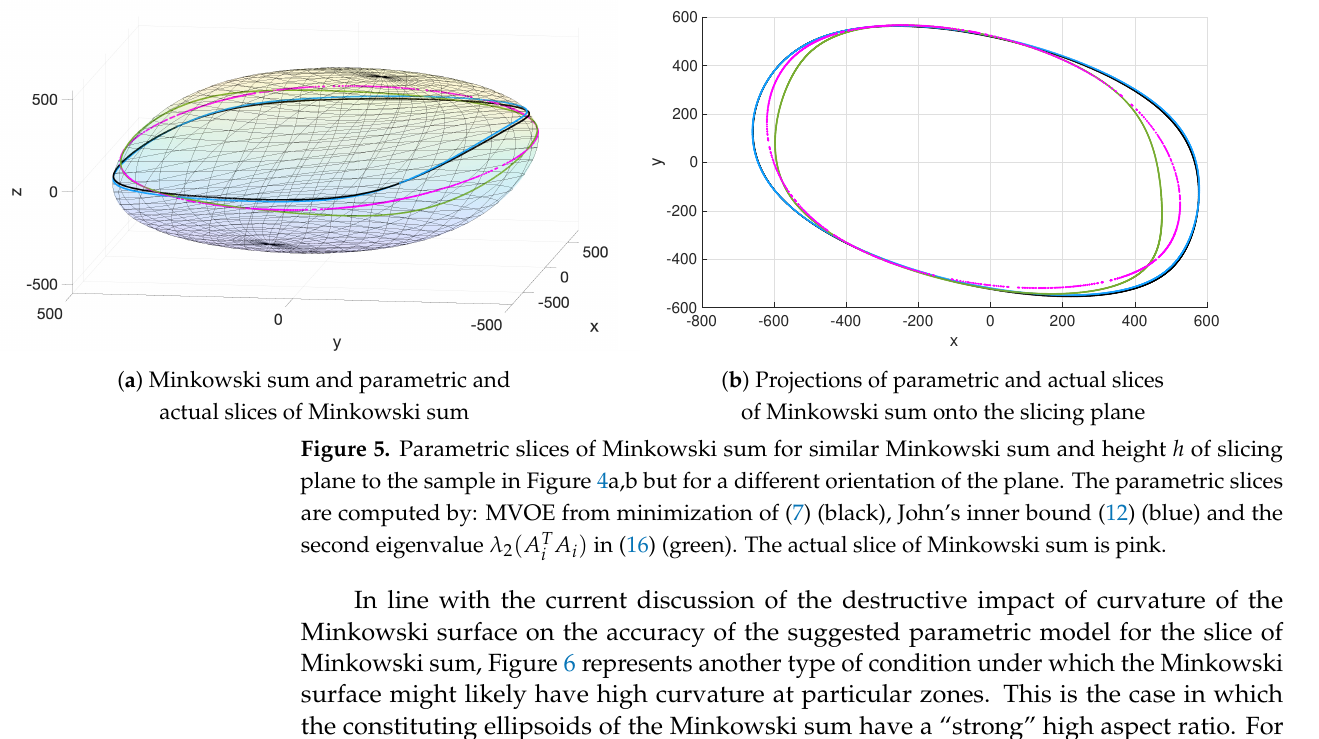
Figure 5 enlightens that the weak consistency of the slice approximations with the actual one, observed in Figure 4c–f, is in fact an indirect consequence of the distance of the slicing plane (actual slice) from the center of the Minkowski sum. This figure shows a similar slicing sample to Figure 4a,b, such that the same Minkowski sum is sliced up by a plane at the same height h but with different orientation. Although, the slicing plane is in the same distance h from the Minkowski center, as in Figure 4a,b, the parametric slices show some discrepancy with the actual one at two corners of the projected (planar) slices (see Figure 5b). These corners of the planar slices correspond to the slicing of the corners of the Minkowski sum with high curvatures (see Figure 5a). In summary, the comparison between Figures 4a,b and 5a,b implies that the inconsistency between the parametric slice and actual slice of Minkowski sum occurs in the case that the curve of the actual slice passes closely through the corners of the Minkowski surface with high curvature, where the parametric model presents lower accuracy of approximation.